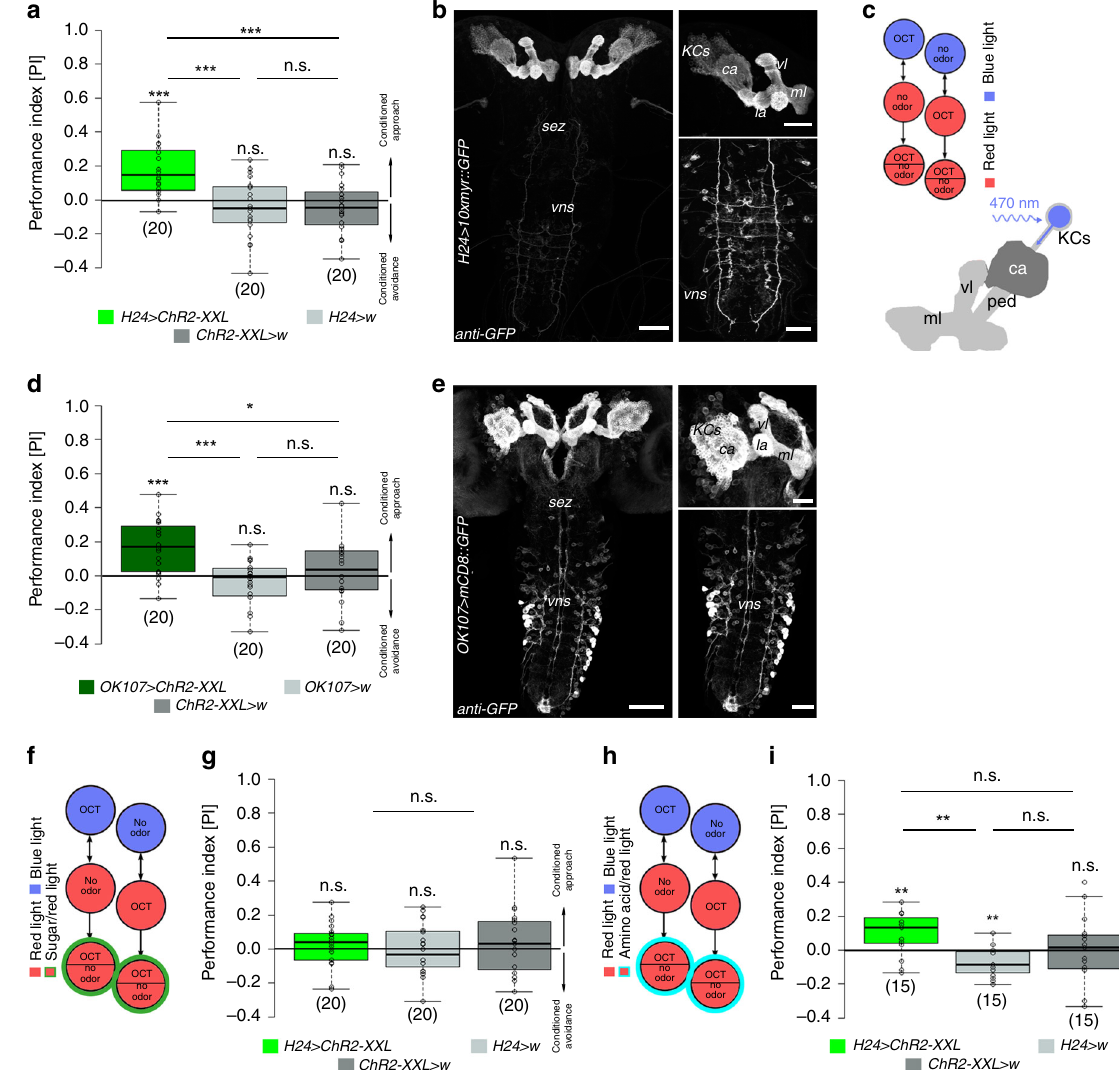
Fig. 1 Optogenetic activation of KCs induces reward memory formation. a Conditional optogenetic activation of KCs coupled to odor information during training is suf fi cient to induce an appetitive memory using H24-Gal4 . b Expression pattern of H24-Gal4 crossed with 10xUAS- myr::GFP stained with anti- GFP (white). H24-Gal4 shows expression in almost the complete set of MB KCs and a few additional cells of the vns. c Illustration of the 1-odor reciprocal training regime used in this study (substitution learning) and a schematic drawing of the larval MB expressing ChR2-XXL in KCs. d Conditional optogenetic activation of KCs coupled to odor stimulation during training is suf fi cient to induce appetitive memory expression ( OK107> ChR2-XXL ). e Expression pattern of OK107 > mCD8::GFP stained with anti-GFP (white). f Schematic drawing of KC-substitution learning using a sugar test plate (green